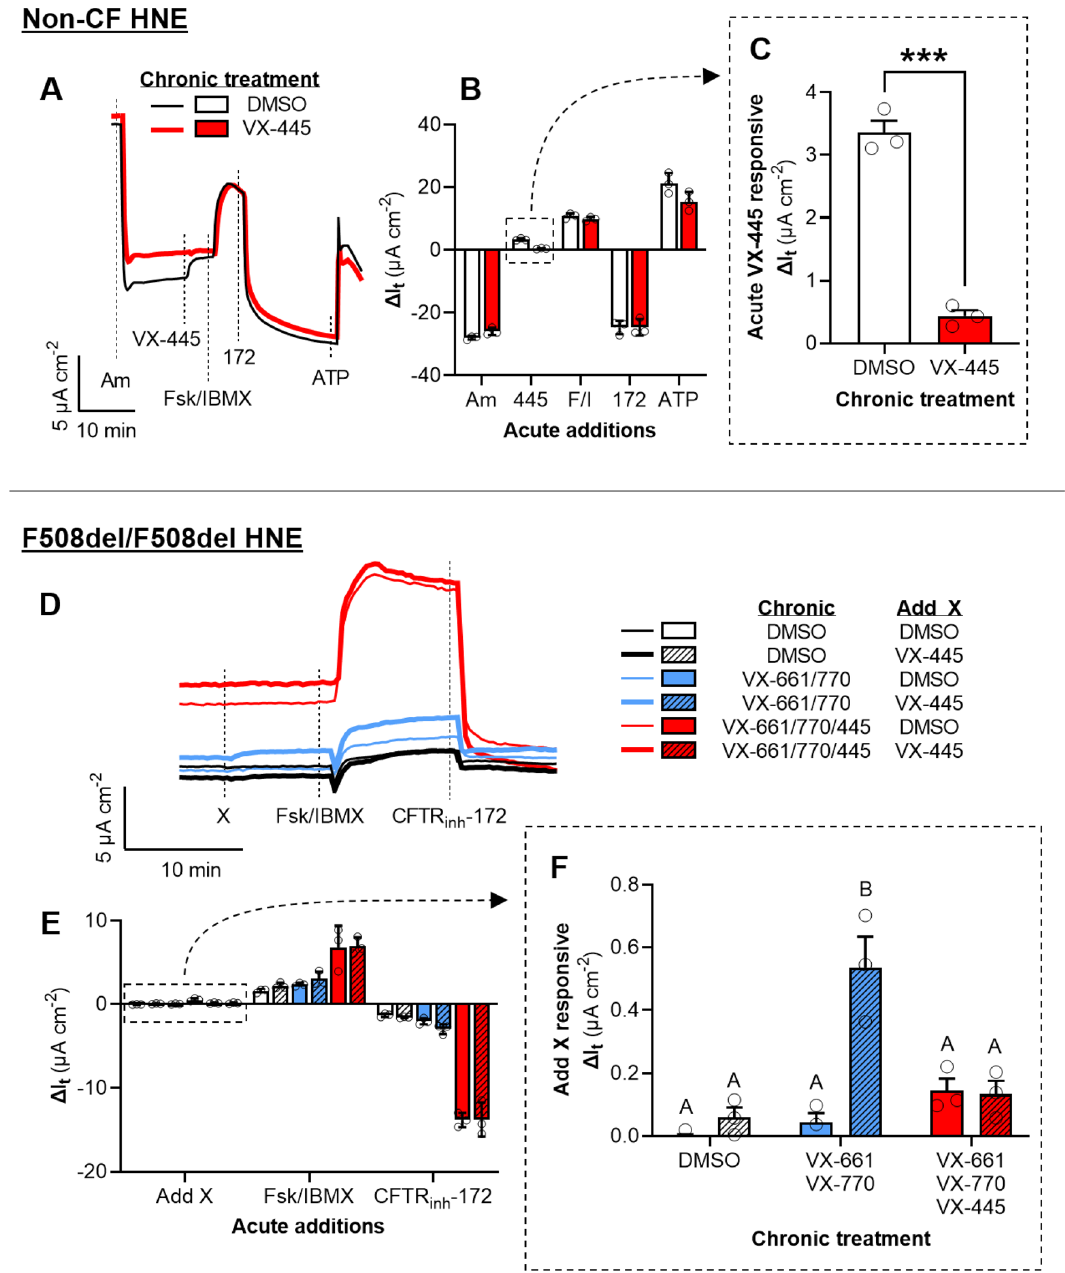
Figure 2. Effect of chronic treatment with elexacaftor (VX-445) includes its actions as both a CFTR corrector and potentiator. ( A ) Representative I t recordings of non-CF HNE treated for 24 h with DMSO or VX-445 (3 µM). ( B–C ) Changes in I t after the additions of test compounds for the experiment presented in Panel A . The potentiating action of VX-445 accounts for the differences in post-amiloride I t between DMSO and VX-445 treated cultures. ( D ) Representative I t recordings of F508del-HNE treated for 24 h with tezacaftor (VX-661; 3 µM), ivacaftor (VX-770; 100 nM), and/or VX-445 (3 µM chronic; 100 nM acute). ( E–F ) Changes in I t after the additions of test compounds for the experiment presented in ( D) . The triple combination of VX-661/77/445 significantly increased CFTR-mediated I t . Acute action of VX-445 in stimulating I t was only observed in VX-661/770 treated F508del/F508del nasal cells. See SI for additional experimental details and for supporting data. All data are presented as mean ± standard error. Bars with different letters (A, B, C…) are significantly different from each other (ANOVA; P < 0.05). Asterisks indicate specific P values: *** P <